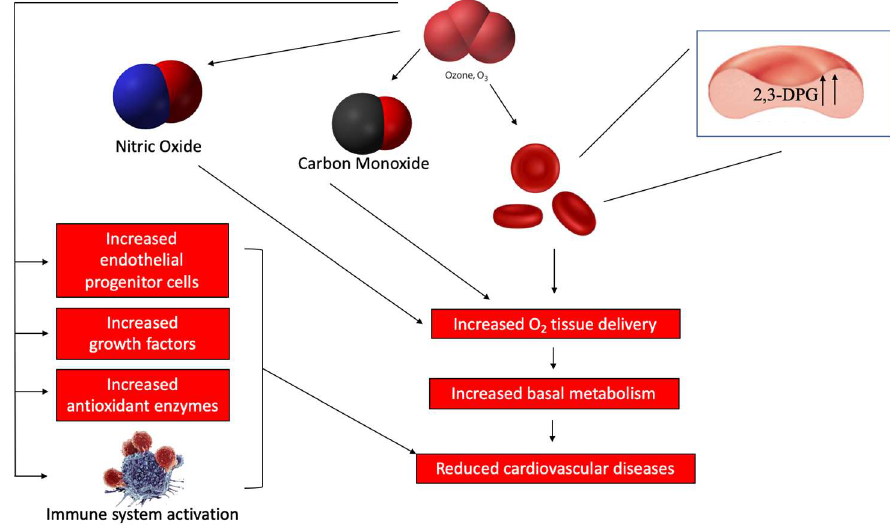
Figure 6. A schematic representation of the possible mechanisms of action of ozone in skin diseases.